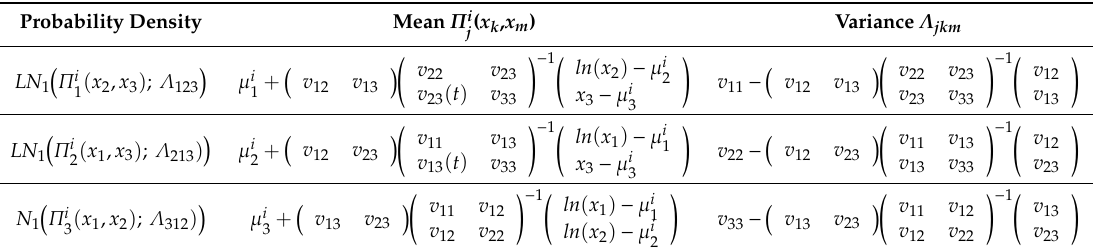
Table 7. Mean and variance of conditional probability density functions with two predictors. Probability